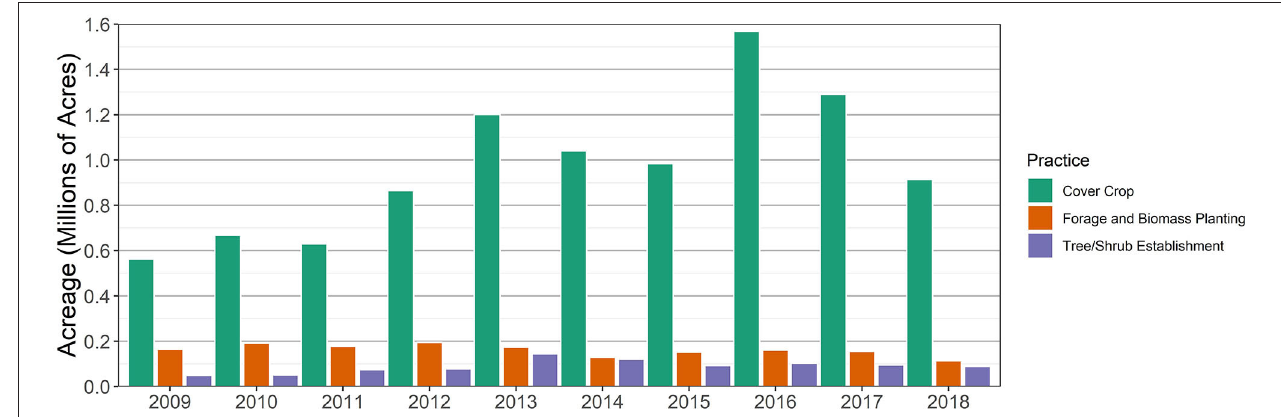
FIGURE 6 | EQIP acreage dedicated to cover crops (green; 340), forage and biomass planting (orange; 512), and tree/shrub establishment (purple; 612) from 2009 to 2018. We focused on these practices because they represented larger percentages of investments dedicated to top categories in our classification system (section Classification Systems Identify Overlapping, Complex Practices With the Largest Potential for Improving Environmental Health, Table 3 ) and were consistently reported in